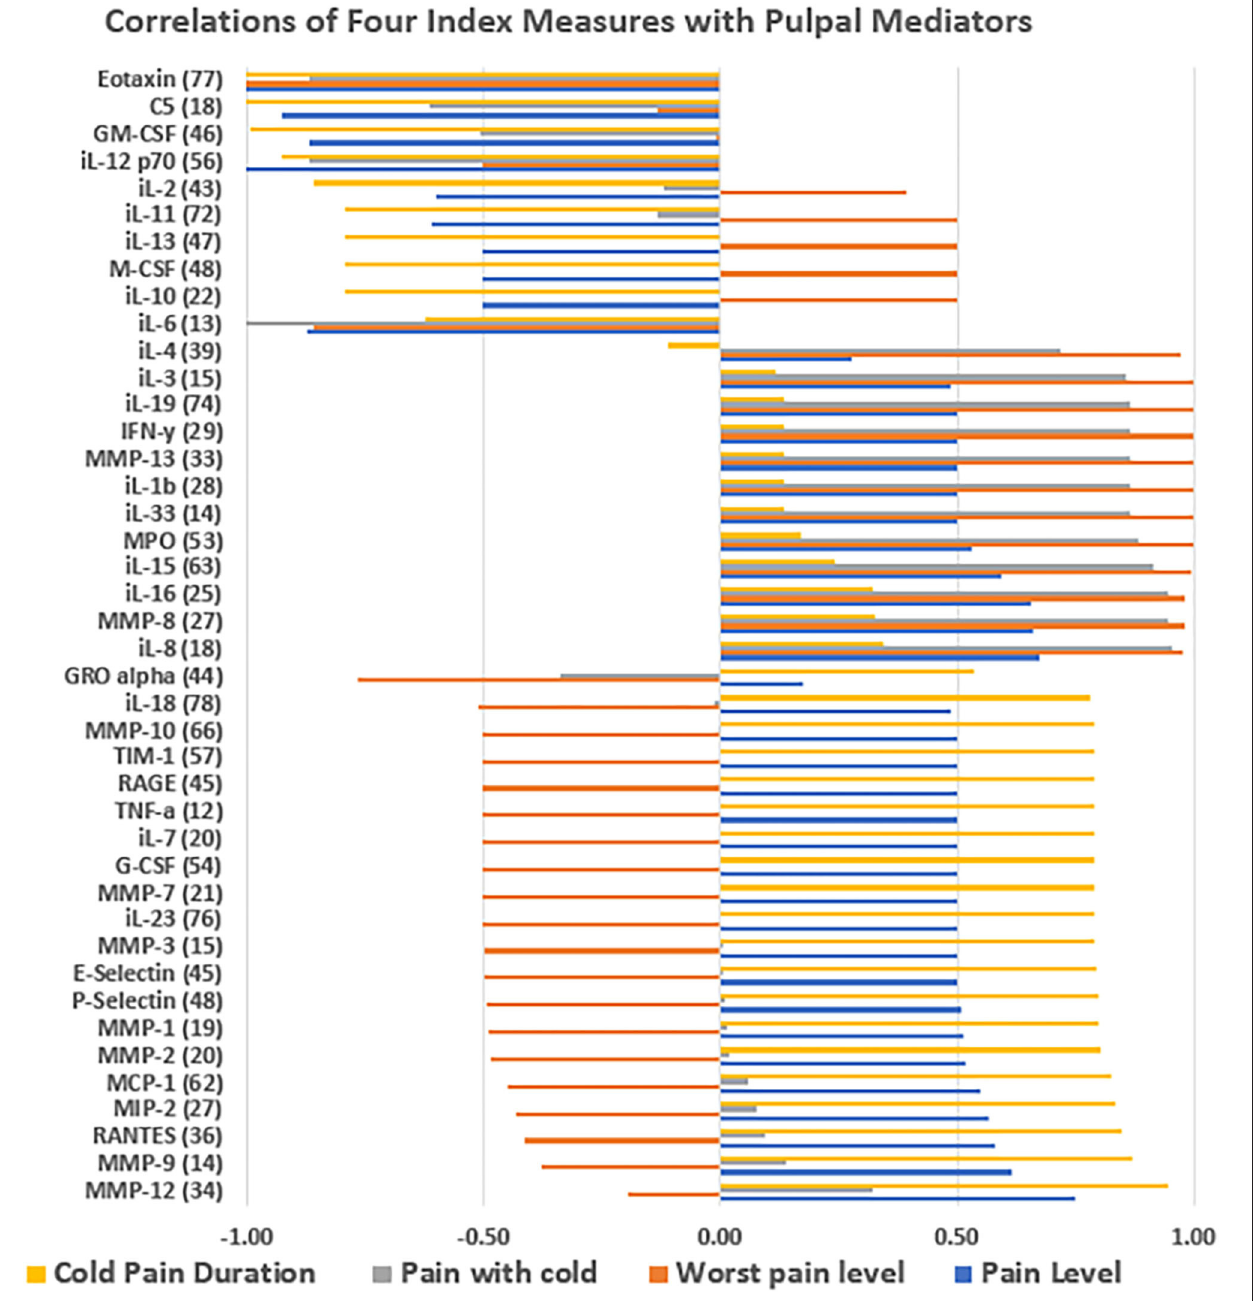
FIGURE 4 | Correlation of four index measures with pulpal mediators: the correlation between the average level of expressed protein mediators from three subjects enrolled in the study and four indices including the severity of pain level on the day of visit, worst pain level experienced since the initial onset of pain, severity of pain with cold testing and duration of pain with cold testing. The X-axis shows positive or negative correlation